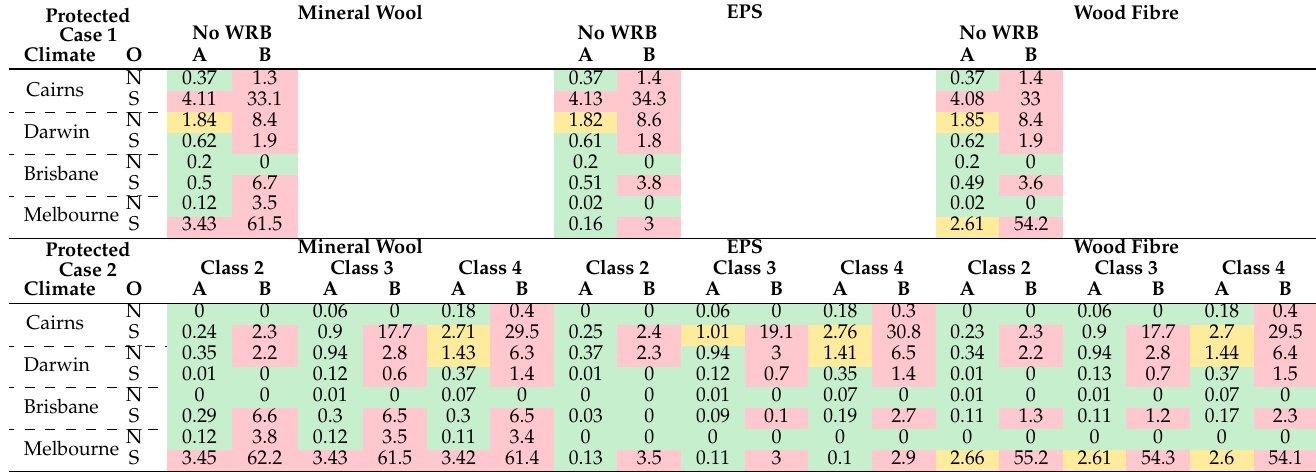
Table 12. Protected CLT results for internal insulation. O (orientation). Performance criteria: A (mould growth index), B (corrosion rate). Classification of WRB: Class 2, 3, and 4 (vapour permeance). Green (pass), red (fail), or yellow (further investigation).